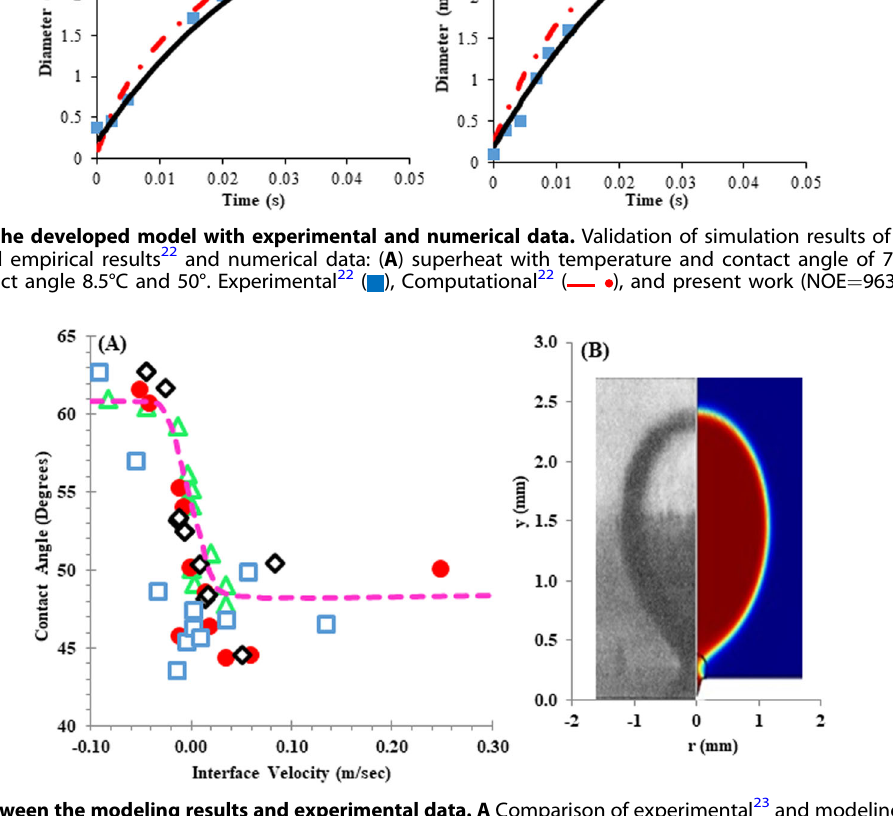
Fig. 2 Comparison between the modeling results and experimental data. A Comparison of experimental 23 and modeling results of dynamic contact angle at bubble base in nucleate pool boiling process. B Comparison of bubble shape prediction modeling result with experimental for Δ T = 8.5 °C and contact angle = 50° 22 . Present work (T w -T sat = 7 °C) ( ), present work (T w -T sat = 8.5 °C) ( ), (T w -T sat = 7 °C) 23 ( ), (T w -T sat = 8.5 °C) 23 ( ), and trend line (